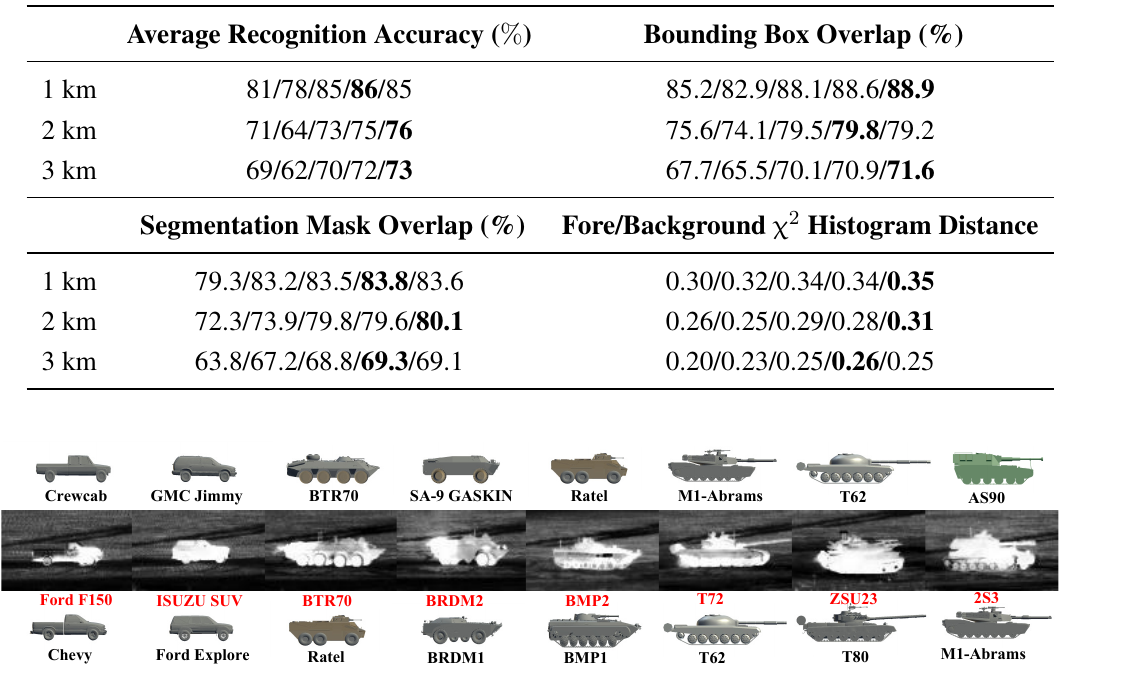
Figure 9. Some sub-class recognition results under 1000 m. The first row and third row show the closest training vehicles along the identity manifold in the CVIM, and the middle row presents the original IR